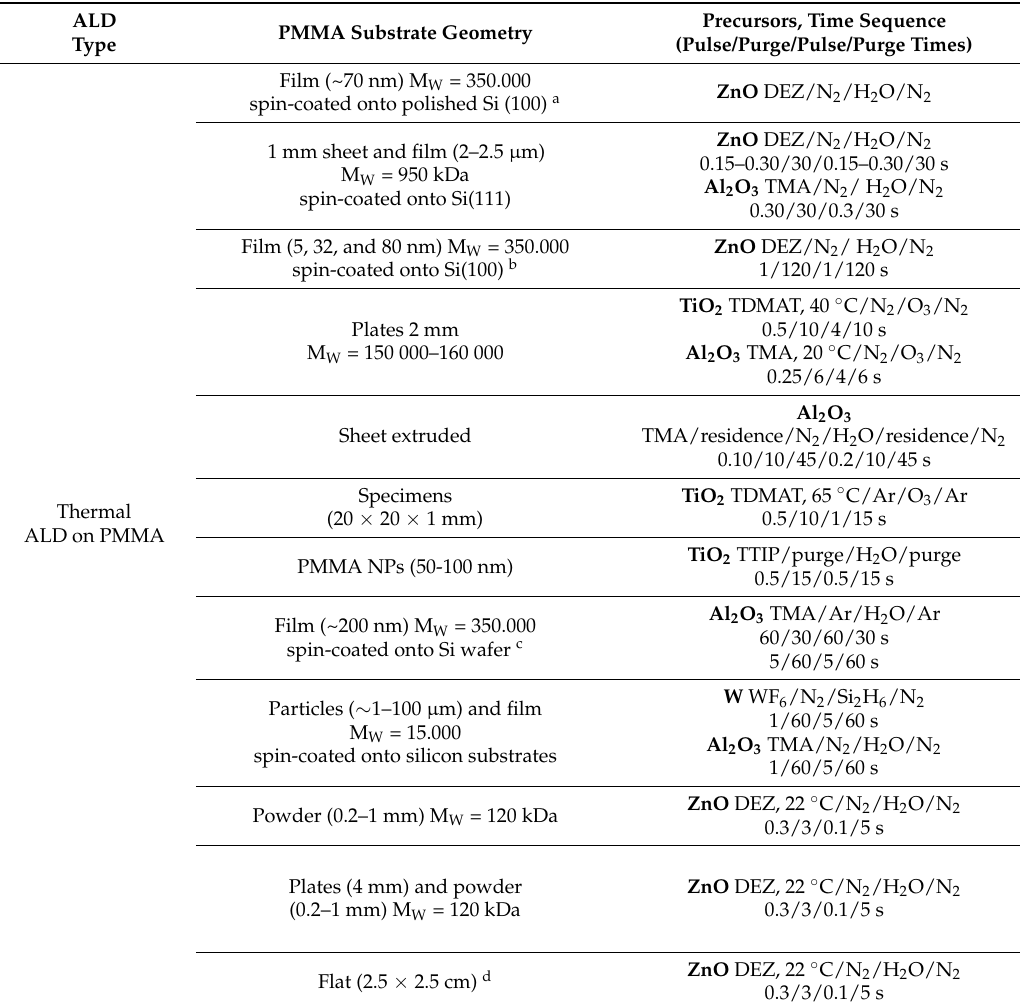
Table 1. Summary of literature data regarding ALD coatings on